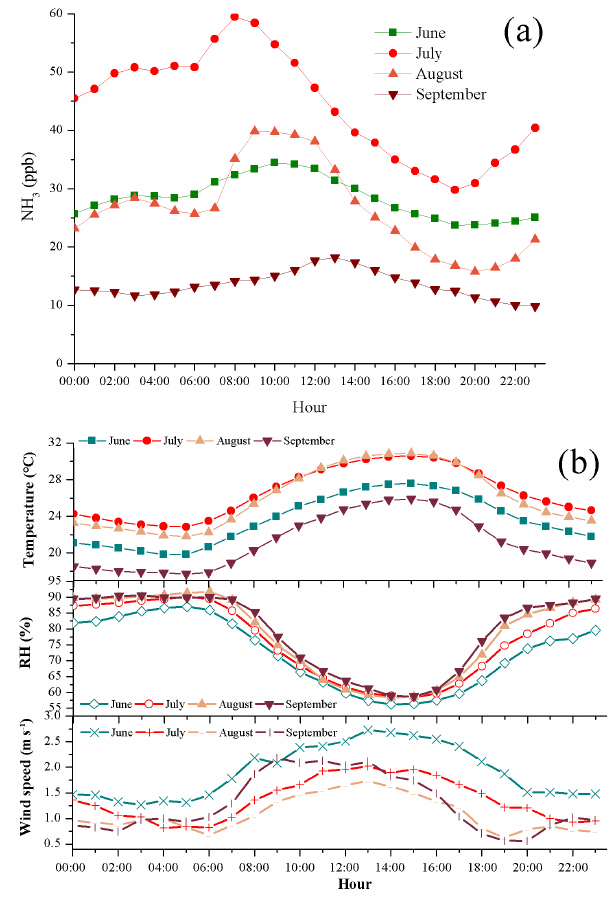
Figure 3. Diurnal variation in NH 3 (a) and meteorological parame- ters (b) during the sampling